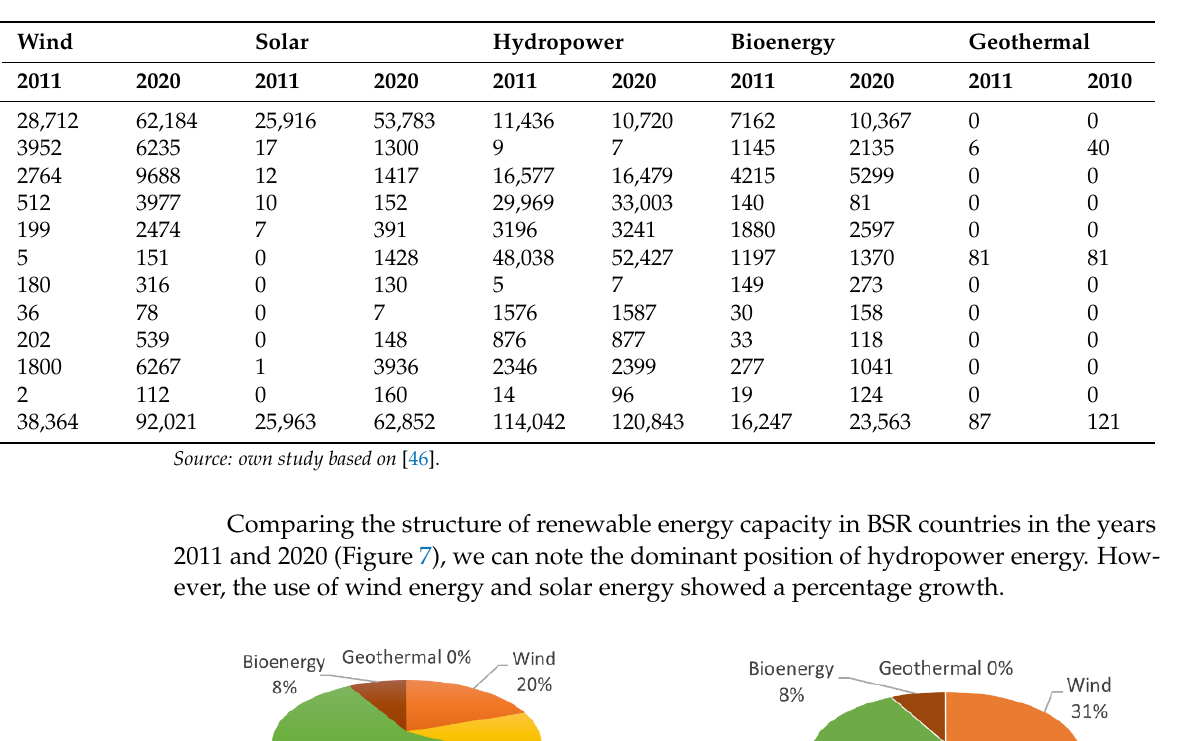
Figure 7. The structure of renewable capacity in BSR countries in 2011 and 2020. Source: own study based [46]. The summary of the renewable energy capacity in EU member states of BSR in 2011 and 2020 is interesting (Figure 8). Analysing the above data, we note a spectacular 132%